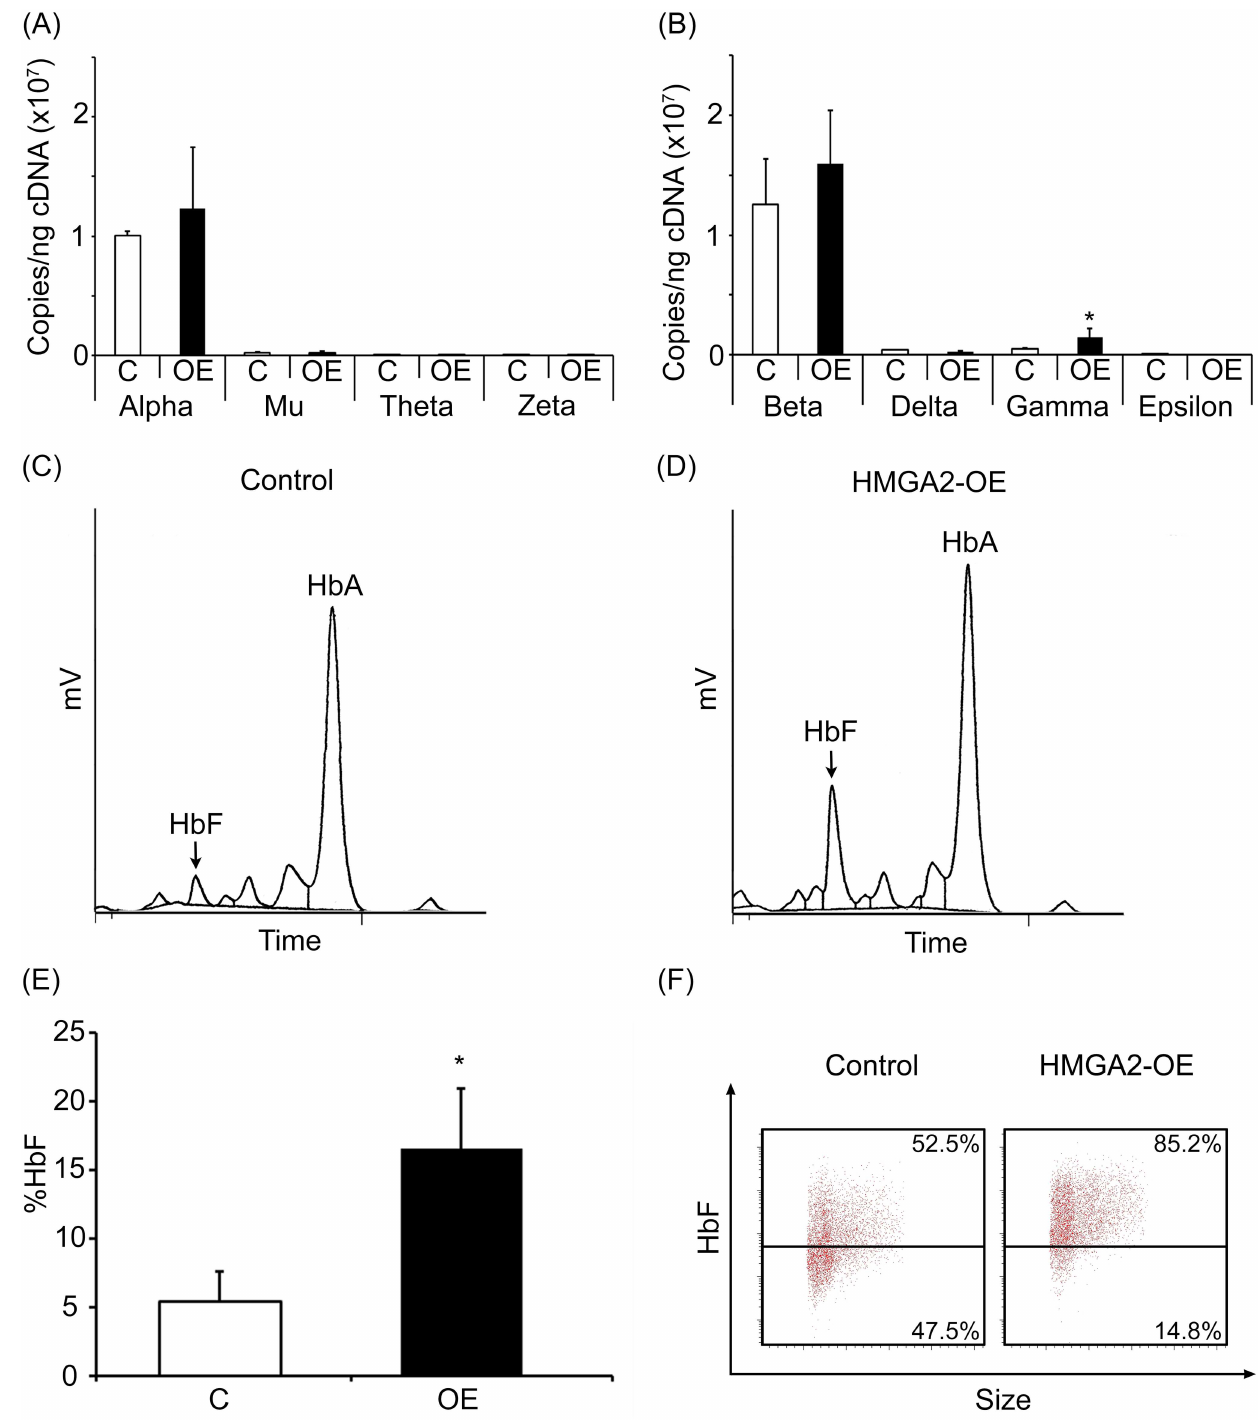
Fig 3. Enforced expression of HMGA2 regulates gamma-globin mRNA and pancellular HbF levels in adult human erythroblasts cultivated ex vivo . Quantitationof copy numberper nanogramcDNA (copies/ngcDNA) by Q-RT-PCR analyseswas performed at culture day 14 for (A) alpha- , mu- , theta- and zeta-globins ,and (B) beta- , delta- , gamma- and epsilon-globins in HMGA2-OE and empty vector control transductions. Representative HPLC profile of hemoglobin collectedat culture day 21 from (C) empty vector control transductions and (D) HMGA2-OE. (E) Average percentage of HbF levels detected by HPLC analysis. (F) Representative flow cytometry dot plots of empty vector control transductions (left panel)and HMGA2-OE (right panel) at culture day 21 stainedfor fetal hemoglobin. Open bar represents empty vector control and black bar represents HMGA2-OE. Mean value ± SD of four independentdonorsfor each condition. P-value was calculatedusing one-tailedpairedStudent’s t-test. C = empty vector control transduction; OE = HMGA2 over-expression. * p < 0.05.